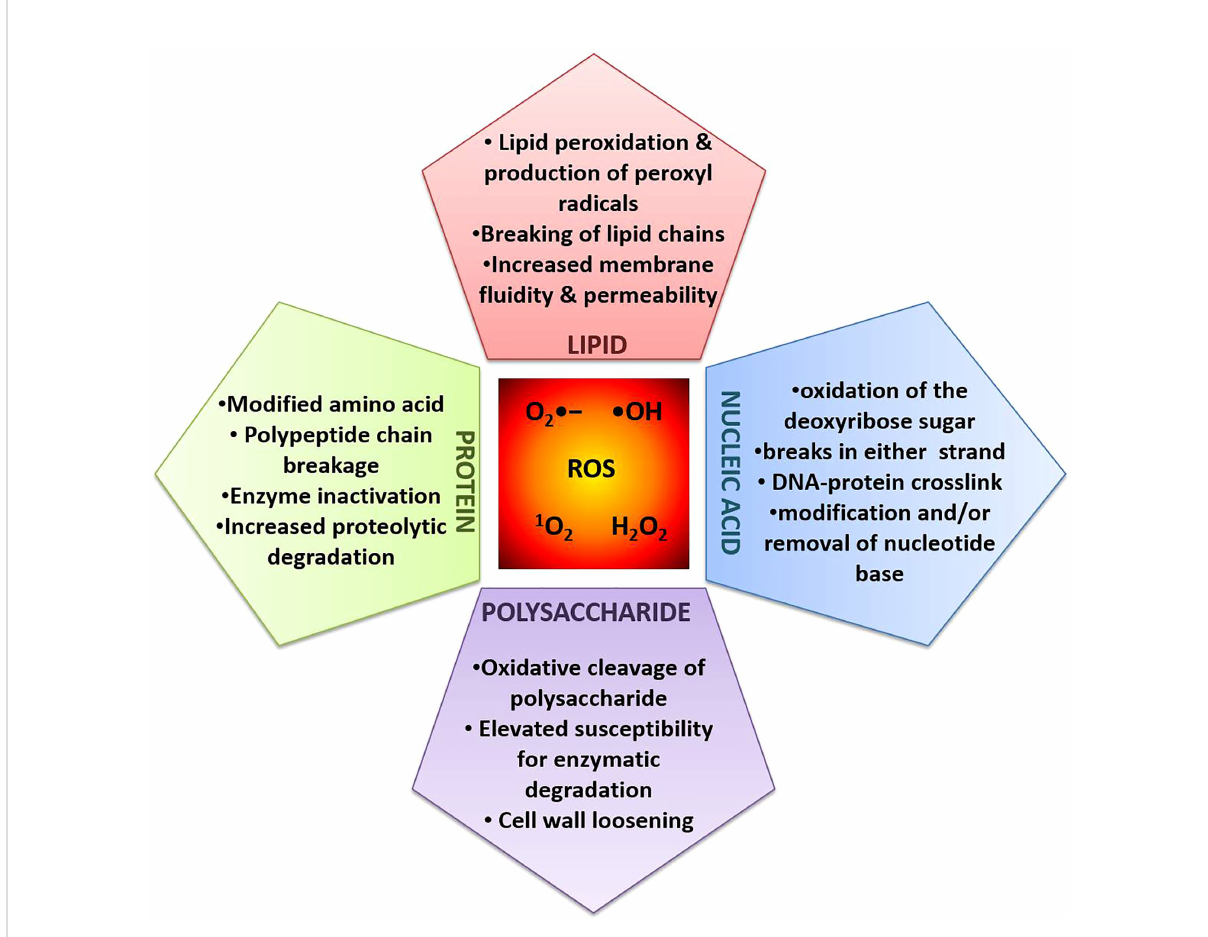
FIGURE 3 Biomolecular targets for ROS induced damage in plant